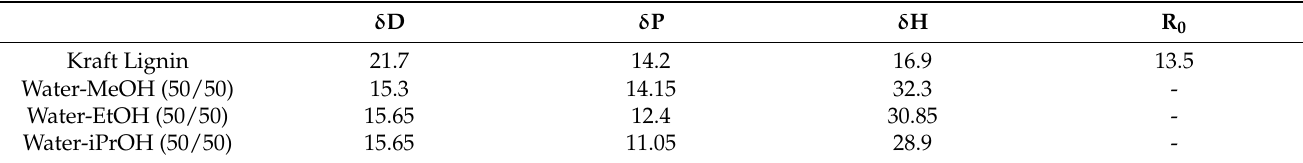
Table 4. Hansen parameters for Kraft lignin solubilization in different solvents